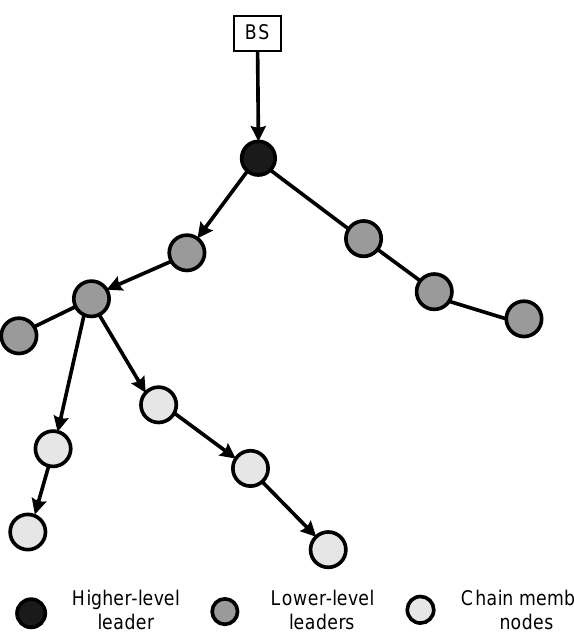
Figure 20. Communication from the BS to the member nodes of a